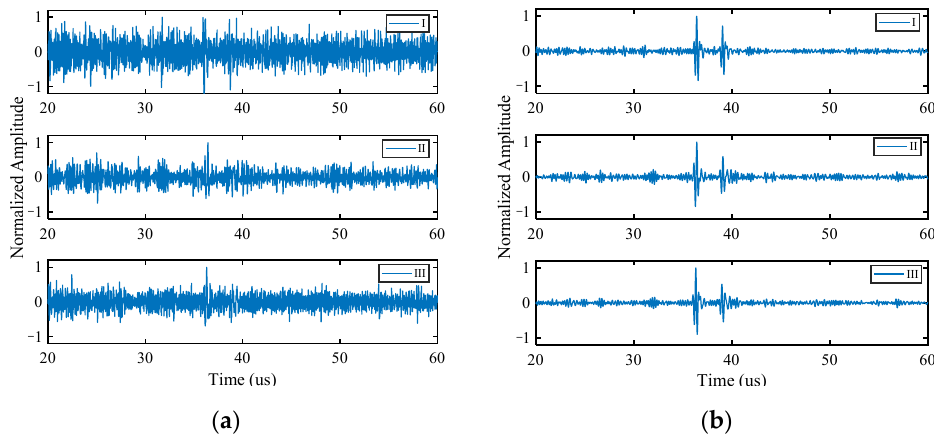
Figure 14. Time domain waveforms of experimental signal. ( a ) Before noise reduction; ( b ) after noise reduction.